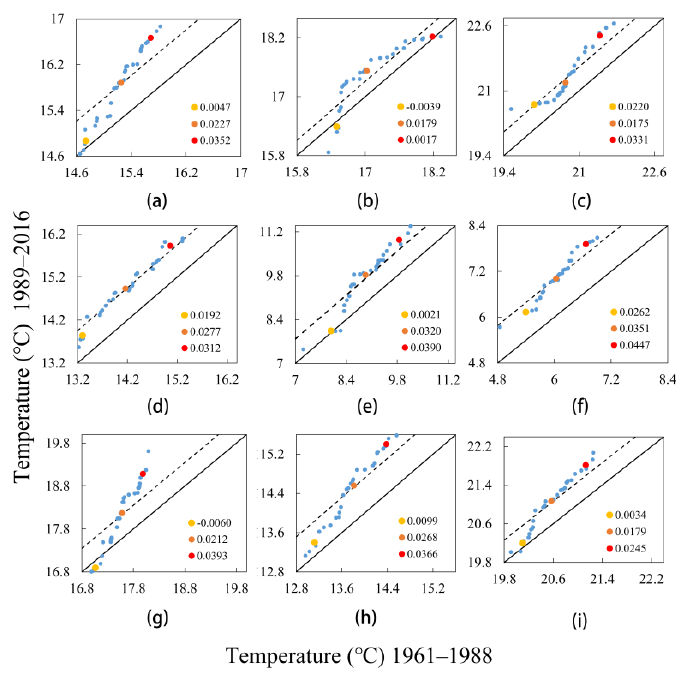
Figure 6. Results of innovative trend analysis (ITA) for the maximum temperature over the whole JRB: ( a ) annual, ( b ) spring, ( c ) summer, ( d ) autumn, ( e ) winter. Annual maximum temperature in the sub-basins ( f ) SRJRB, ( g ) UPJRB, ( h ) YLRB, and ( i ) MLJRB. Yellow, orange, and red points denote the mean central points of the low, medium, and high categories, respectively.